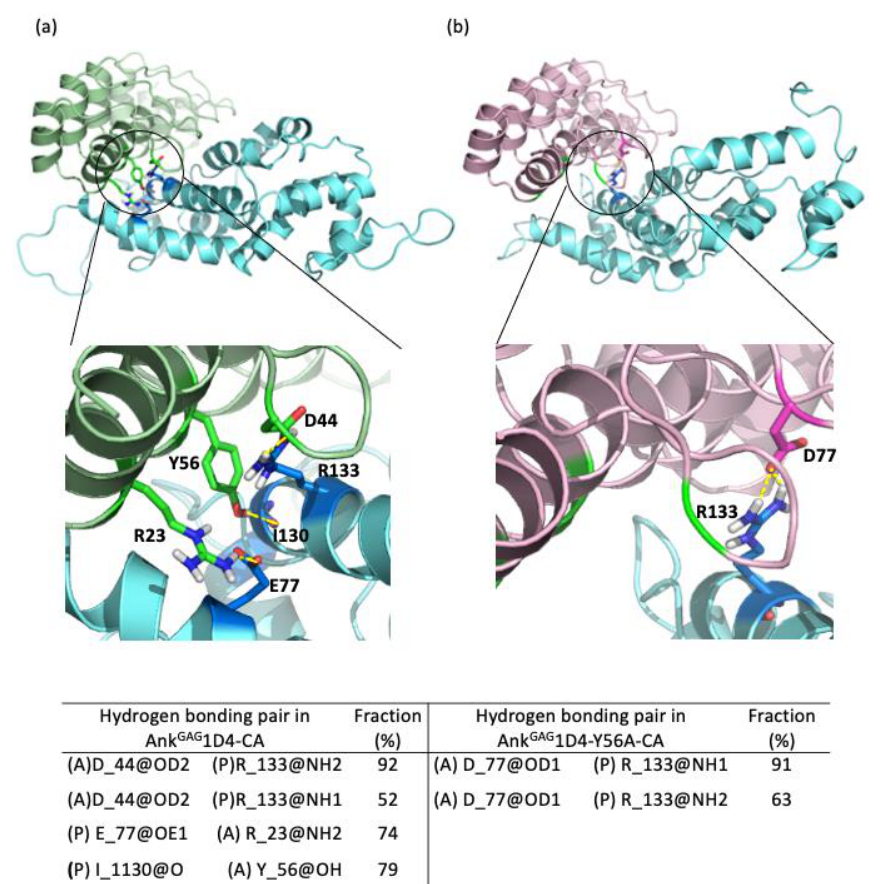
Figure 3. Important hydrogen bonding pairs of both the ( a ) Ank GAG 1D4-CA and ( b ) Ank GAG 1D4-Y56A-CA complexes. R23, D44, and Y56 (green sticks) of Ank GAG 1D4 making hydrogen bonds with CA (blue sticks) while the hydrogen bond between D77 and R133 in Ank GAG 1D4-Y56A-CA is shown in pink and blue sticks. R23, D44, and Y56 that are making hydrogen bonds with the CA in Ank GAG 1D4-CA are at a distance that is too far to establish hydrogen bonds at the Ank GAG 1D4-Y56A-CA complex (green shading in b). The table lists the hydrogen lifetime where (A) denotes residues from Ank GAG 1D4-CA/Ank GAG 1D4-Y56A while (P) denotes residues from CA.